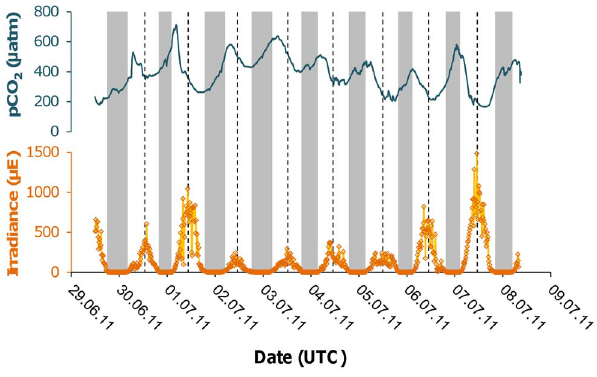
Figure 2. Comparison between Light and pCO 2 series in July. Dark bands: period of darkness. Dashed lines: estimated center of the daylight distribution.